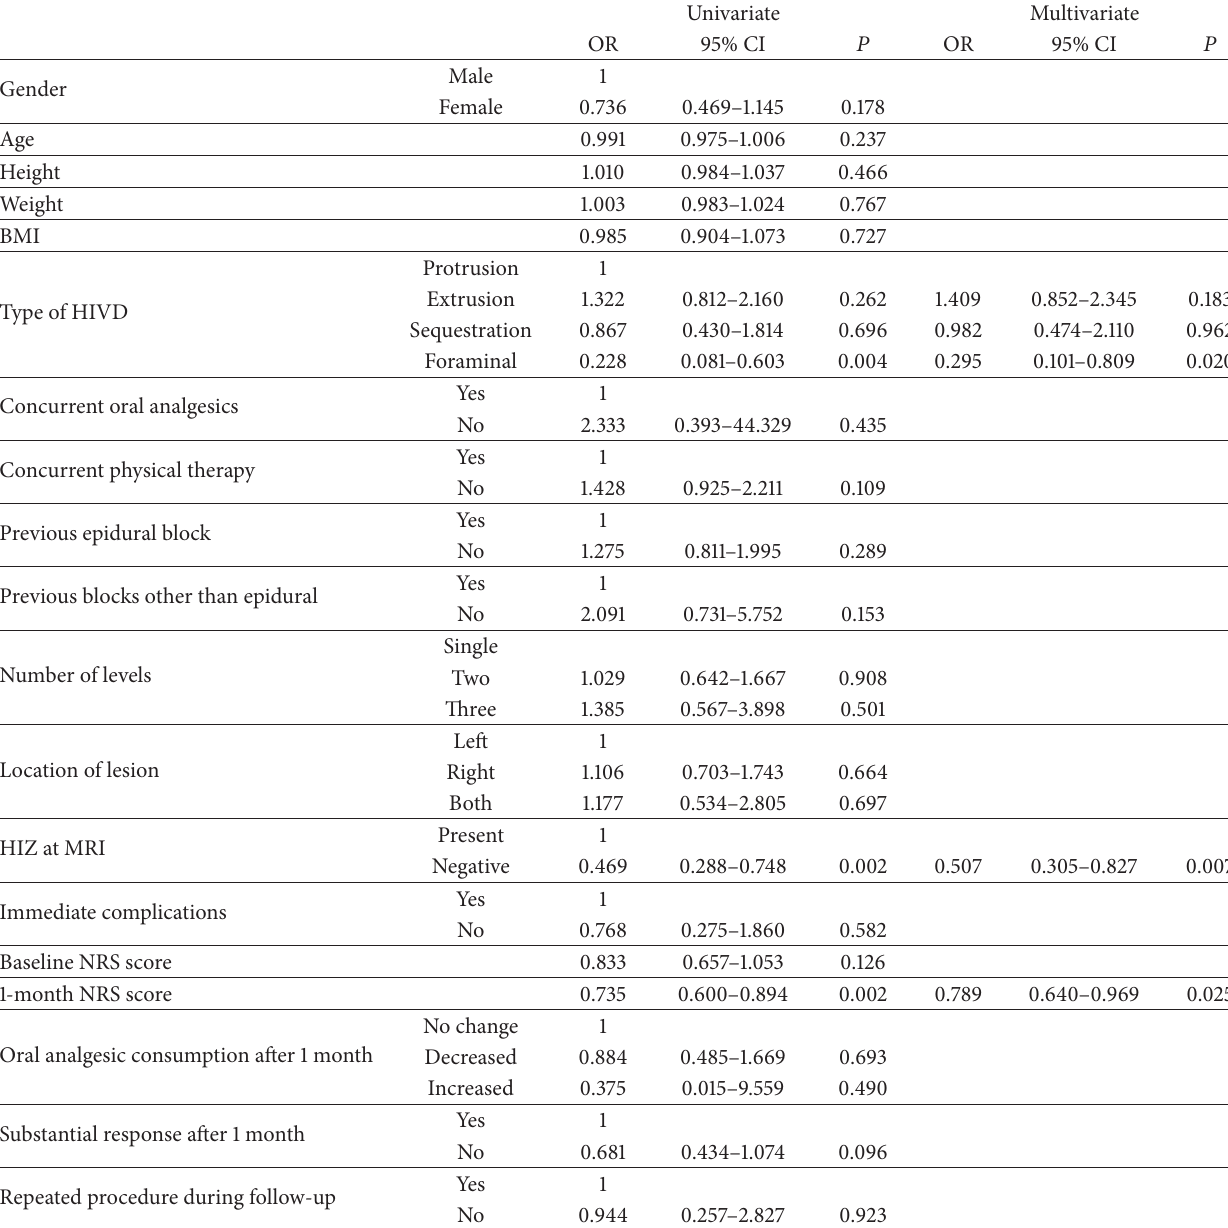
Table 3: Univariate and multivariate analyses of variables that predict a substantial response 1 year after percutaneous epidural